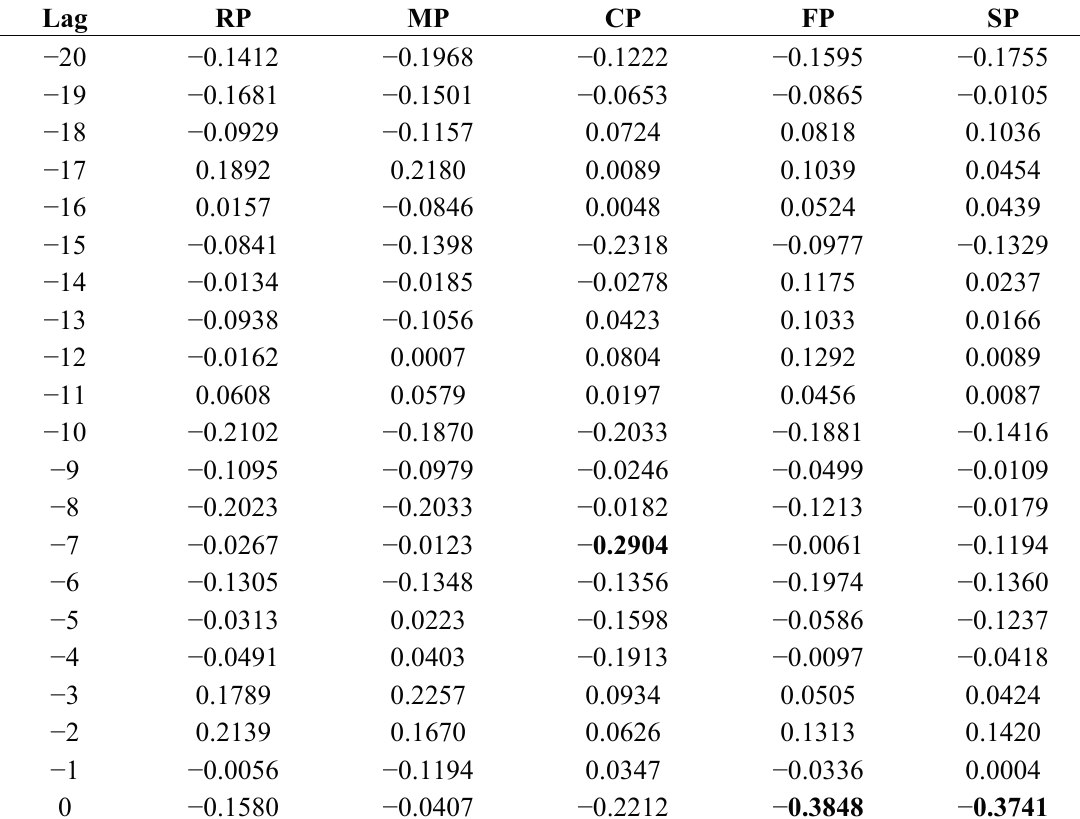
Table 6. Correlation coefficients between the Southern Oscillation Index (SOI) and annual rainfall time series for the Pampa